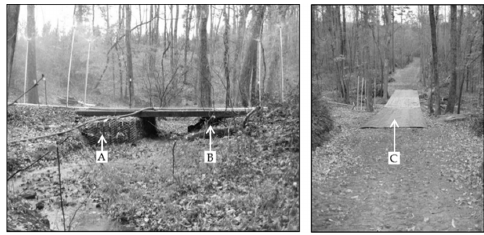
Figure 1. Left : Bridge during rainfall simulation on best management practice (BMP+) treatment with gabion basket ( A ) as an abutment (left of stream) with the native slope as the opposite abutment ( B ) and the road running surface and bare soil rocked; Right : Bridge prior to application of rock over the geotextile fabric ( C ) on the running surface of the road (BMP-std); picture shows geotextile prior to rock application which completed the BMP-std treatment.